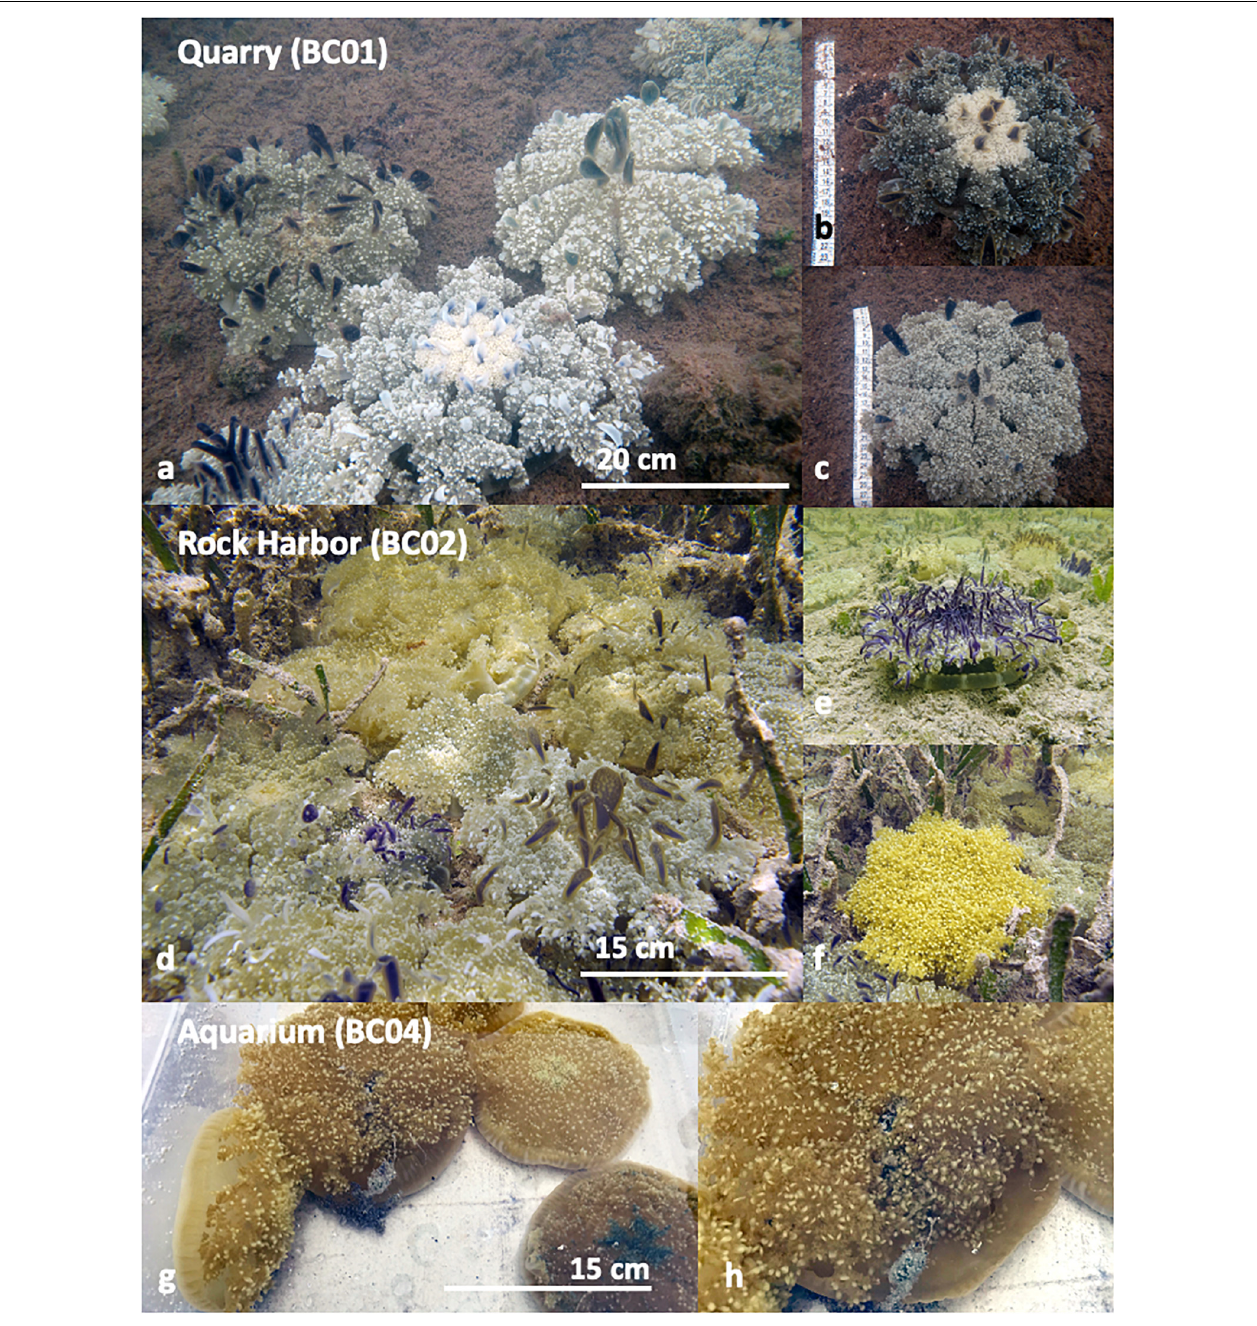
FIGURE 1 | Cassiopea medusae at Upper Keys collection sites: (a–c) Quarry (BC01). (a) Large C. xamachana medusae in patches of high abundance ( n = 5 in view), on the substrate, but not overlapping, approximately 17–30 cm diameter. (b) Large individual C. xamachana medusa. (c) Large individual C. xamachana medusa. (d–f) Rock Harbor (BC02). (d) Medium to large C. xamachana and C. frondosa medusae on the substrate in high abundance ( n = 16 in view), overlapping one another, approximately 15–20 cm diameter. (e) Medium individual C. xamachana medusa. (f) Medium individual C. frondosa medusa. (g,h) Aquarium (BC04). (g) Medium C. frondosa medusae in aquarium with water from the local source. (h) Close up on medium C. frondosa medusae from (g) , showing mucus being released. No Cassiopea medusae were photographed from BC03, as only a few small medusae were witnessed. Sampling locations mapped in Figure 6 .